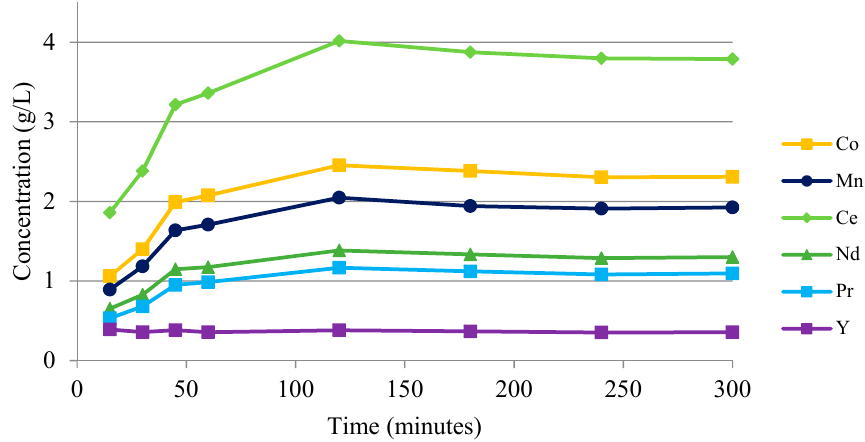
Figure 3. Leaching of anode material with 2 mol/L sulfuric acid at 25 °C (Exp. 2A).